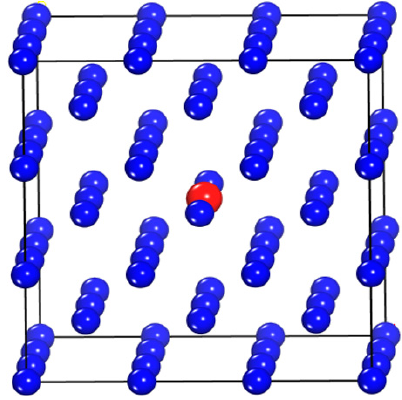
Figure 1. The atomic arrangements of the W-TM (TM = Cr, Cu, Fe, Mn, Mo and Ni, respectively) alloys in a 3 × 3 × 3 supercell. Small blue and large red balls are W and TM impurities atoms,